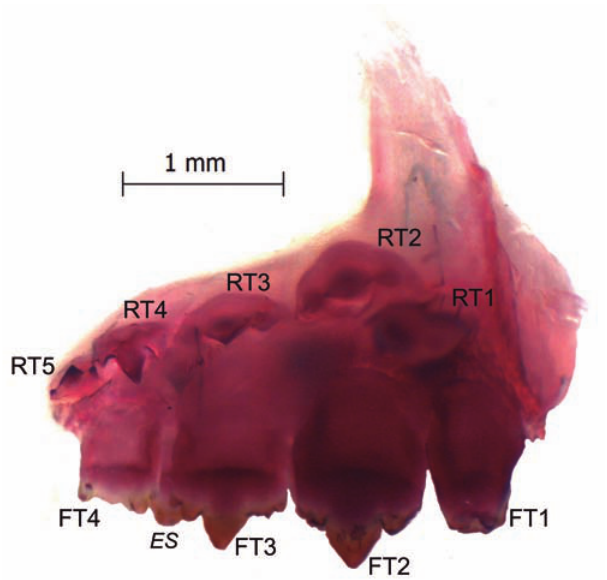
Fig. 3. Astyanax eremus , new species, MCP 46942, 71.9 mm SL, paratype. Posterior view of the left premaxillary bone. Tooth of the outer premaxillary row (ES). Functional tooth of the inner premaxillary row (FT). Replacement tooth of the inner premaxillary series